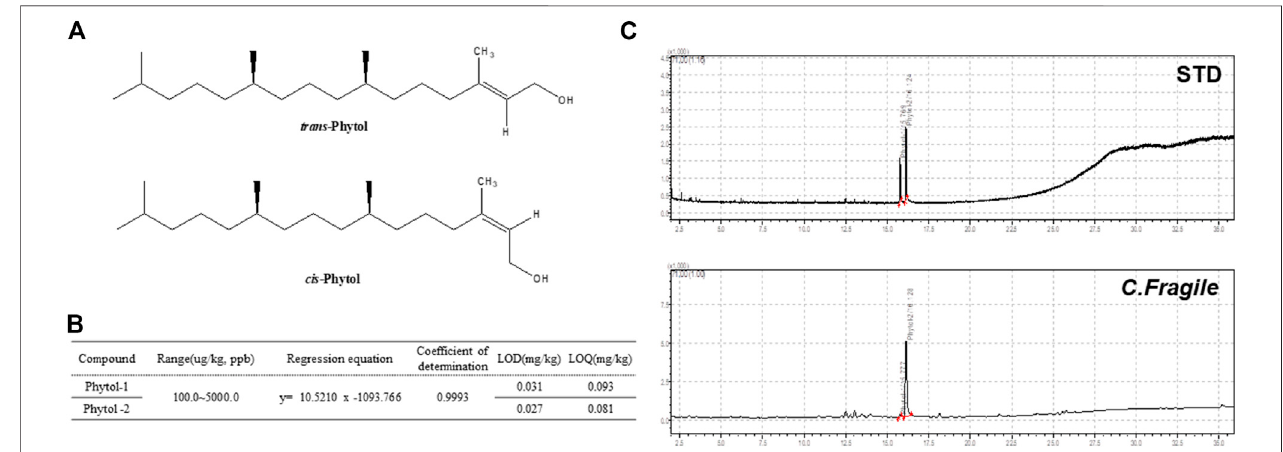
FIGURE 6 | Analysis of C. fragile ethanol extract by using GC-MS (A) Structure of trans -phytol and cis -phytol. (B) Regression equations, LODs, and LOQs of phytol-1 and phytol-2. (C) GC-MS chromatogram of a mixture of phytol isomers standard and C. fragile ethanol extract.